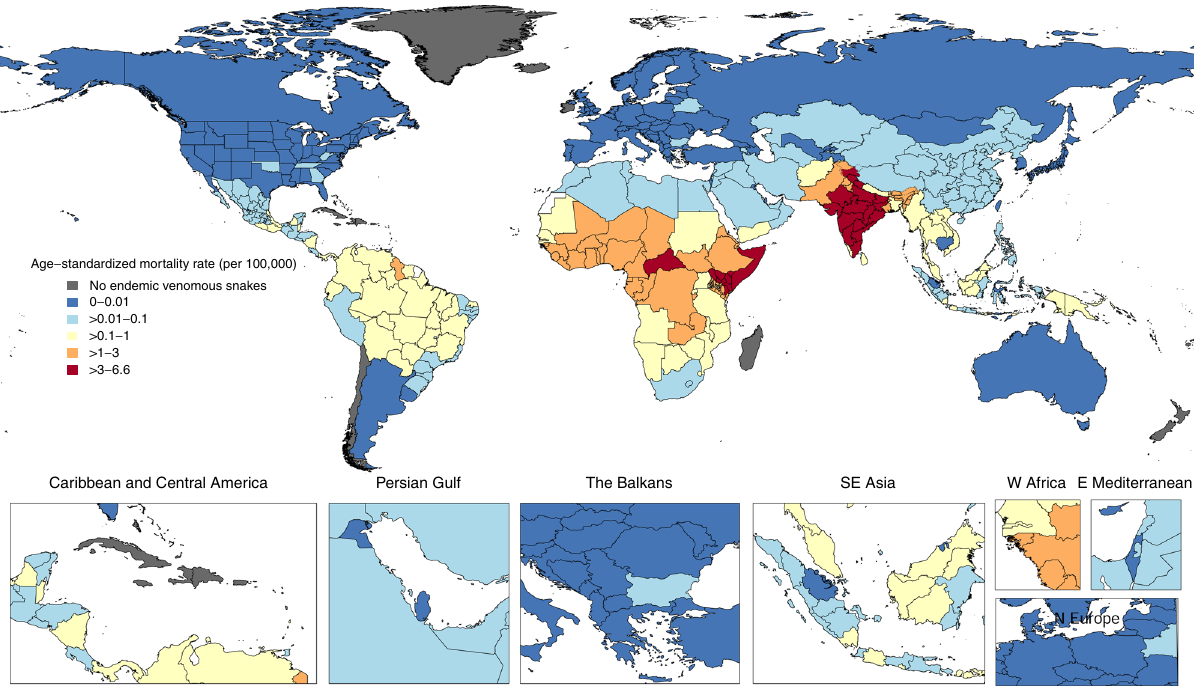
Fig. 2 | Age-standardized mortality rate of snakebite envenoming in 2019 across 204 countries and territories. Age-standardized snakebite envenoming mortality rates across both sexes combined in 2019. GBD 2019 did not publish state-level estimates for China, so each state is colored based on China ’ s national